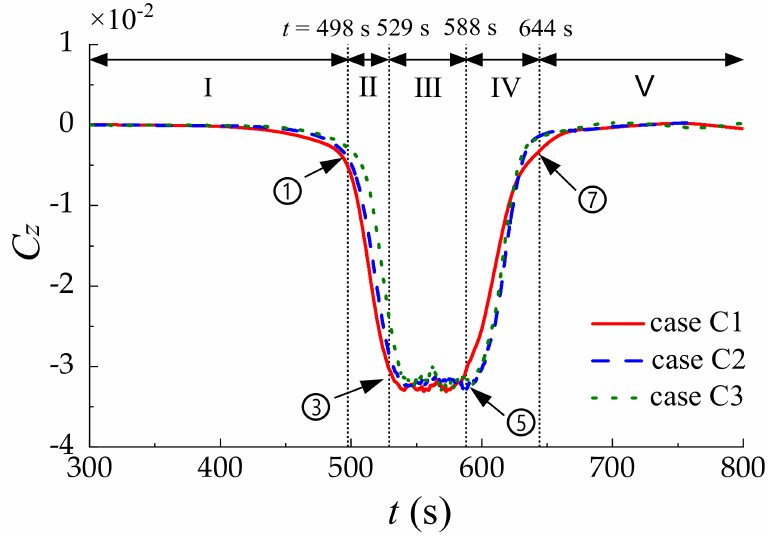
Figure 17. Time series of vertical forces with different navigating speeds.